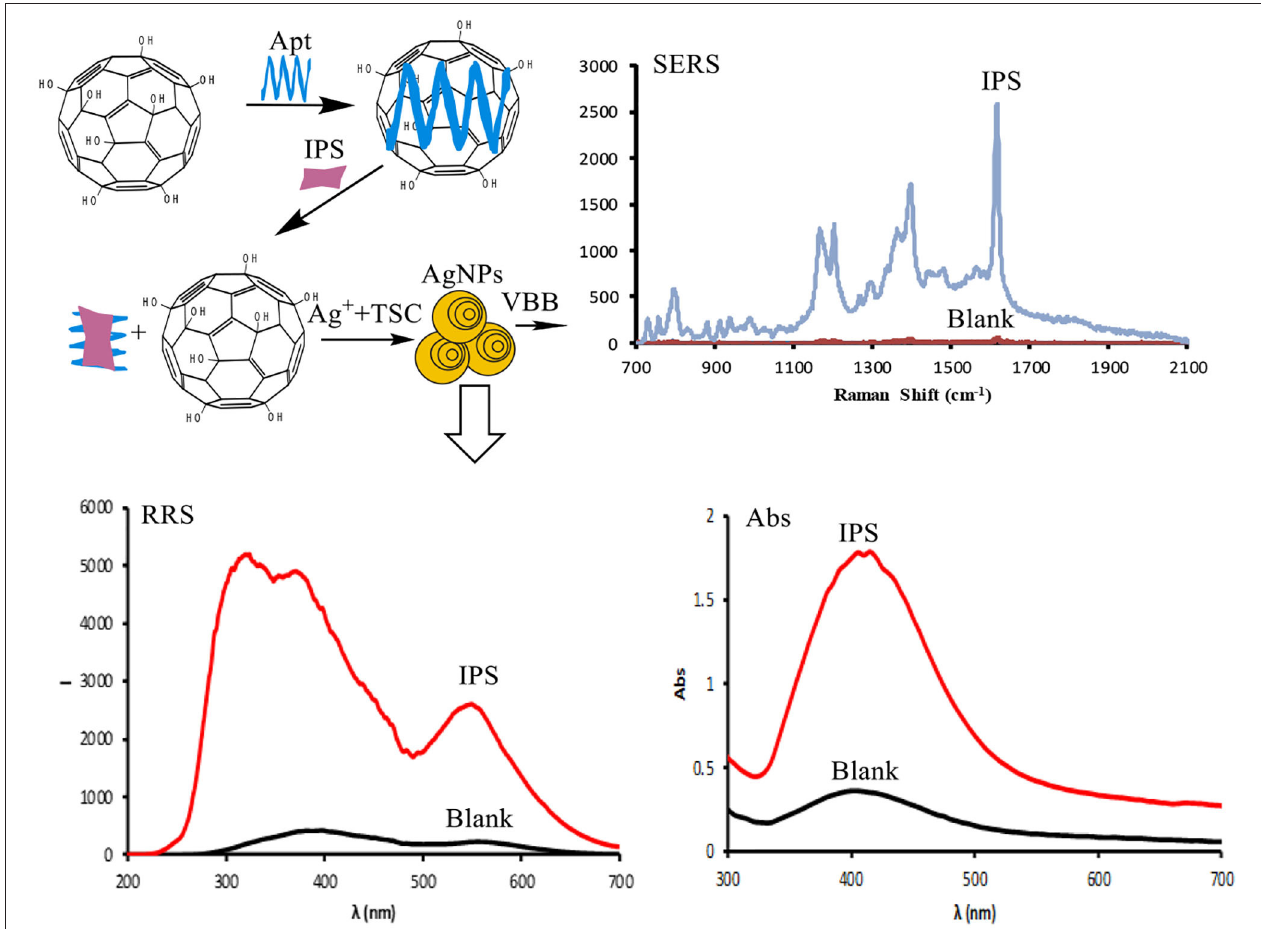
FIGURE 1 | An aptamer trimode analytical platform for IPS based-C 60 (OH) n catalytic amplification and AgNP trifunctional